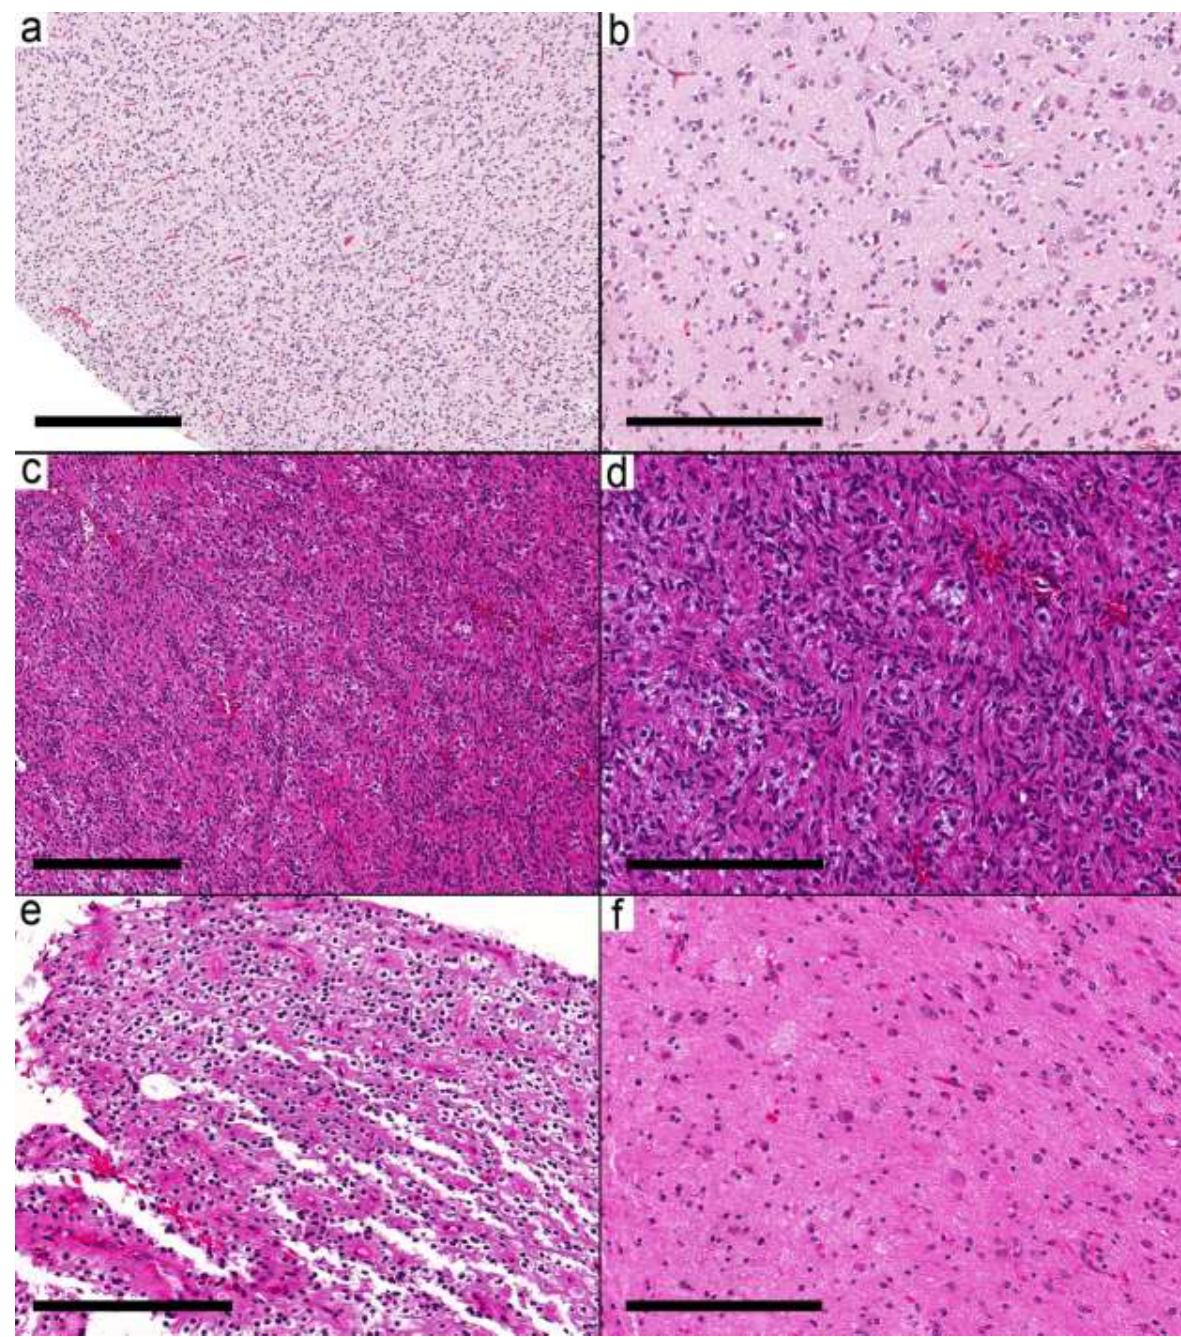
Figure 5. Low-grade glial/glioneuronal tumor. ( a , b ) Case 29 shows a cortex with subtle near-normal appearing neurons and infiltrative-looking oligodendrocyte-like cells similar to the infiltrative pattern in ganglioglioma. ( c , d ) Case 32 shows a cortex infiltrated by elongated cells with a prominent perivascular arrangement that resembles angiocentric glioma. ( e ) Case 33 showing areas with oligodendrocyte-like cells with perinuclear halos and prominent cell membranes. ( f ) Adjacent focus shows scattered dysmorphic ganglion cells and a nonspecific glial background. Scale bars: 300 µm ( a , c ); 200 µm ( b , d – f ).